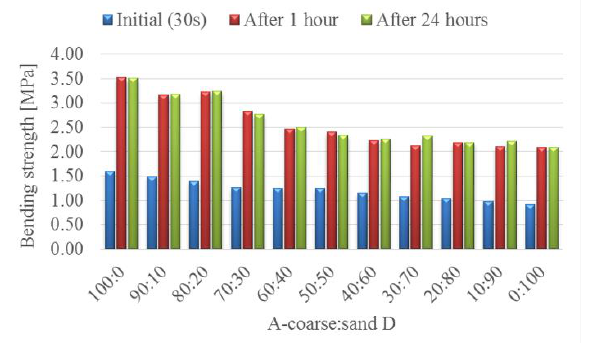
Figure 16. Strength behavior for sand combination A coarse and sand D.